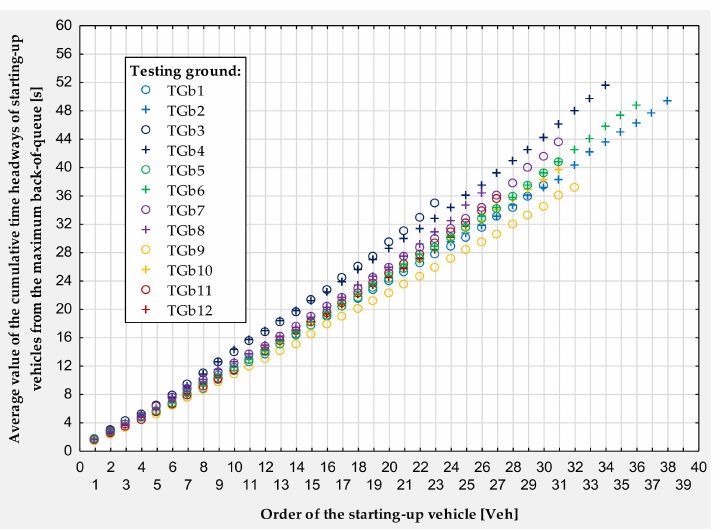
Figure 9. Results of the analysis of average values of cumulative time headways in the stream of starting-up vehicles from the maximum back-of-queue after turning on the green signal in a given cycle for subsequent